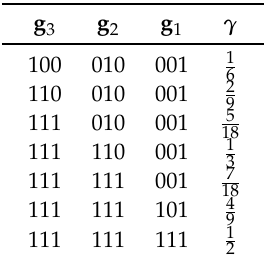
Table 2. The construction of generated codewords under dimming factor γ = 1